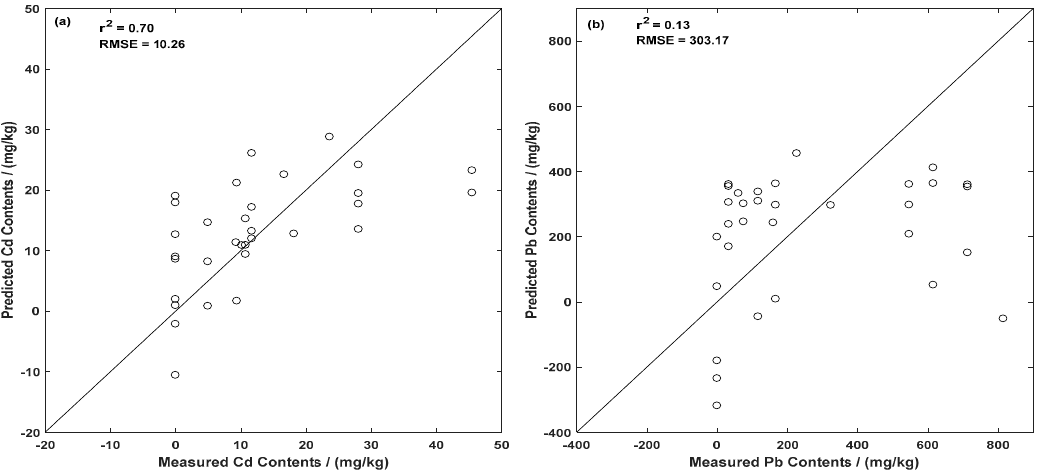
Figure 5. Predictions of Cd contents ( a ) and predictions of Pb contents ( b ) in cross-stress based on partial least squares regression (PLSR).